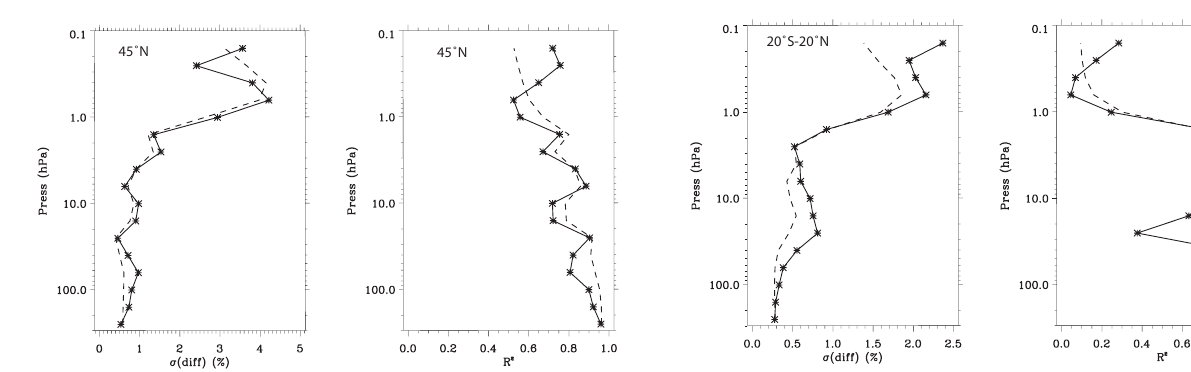
Fig. 17. Same data as used in Fig. 11, except that σ and R 2 are computed for partial column O 3 above pressure levels marked by ∗ . Smoothing has little effect implying that SBUV can provide robust estimates of the partial column O 3 for constraining models, for providing O 3 over-burden above ozonesonde burst altitude, and for cross-calibrating satellite data. Increase in σ in the mesosphere may be due to diurnal effects.